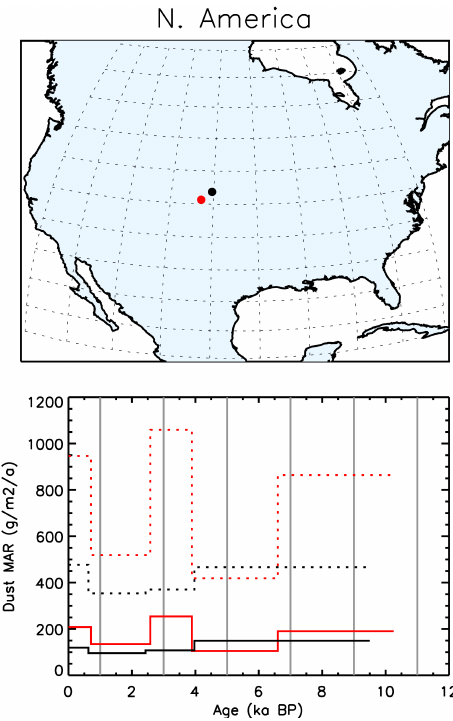
Figure 8. Same as Fig. 6 but for the North American